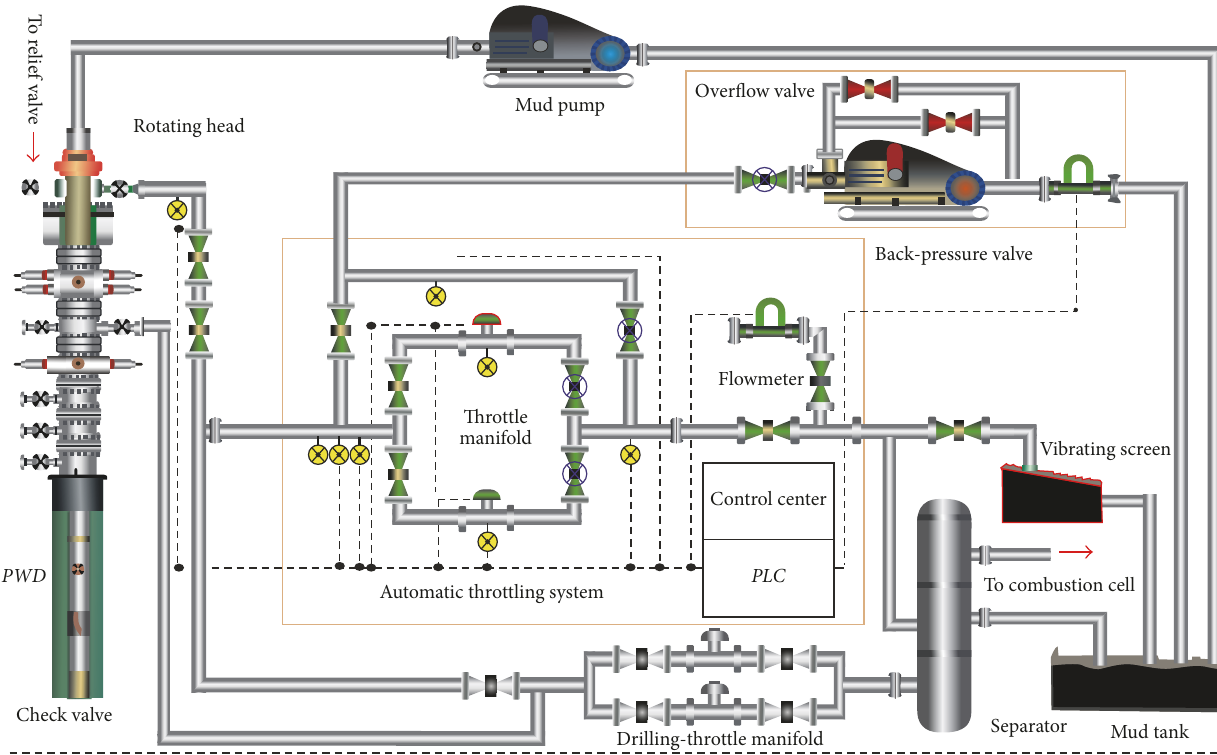
Figure 1: Flow chart of underbalanced